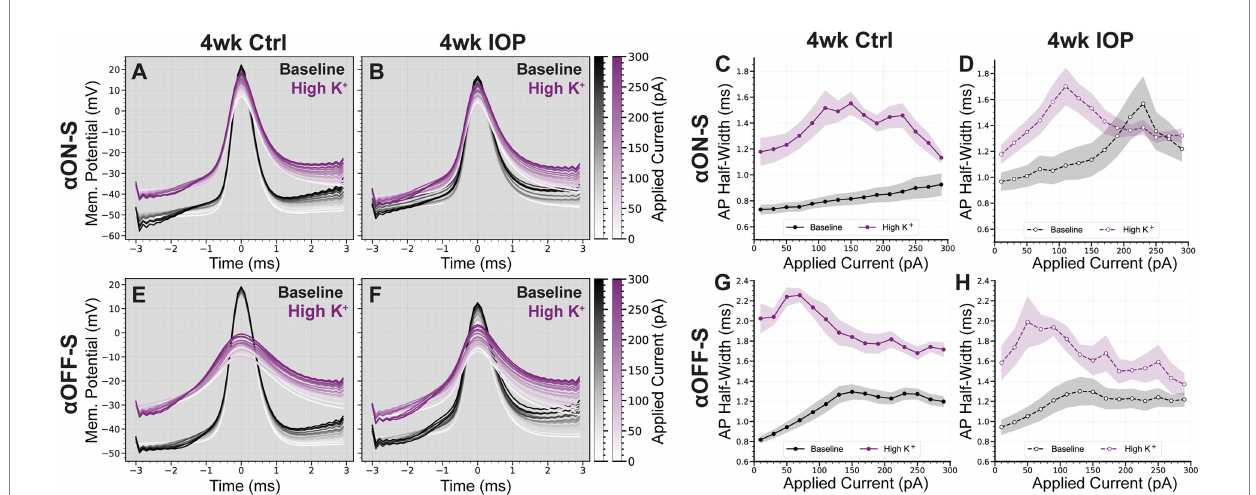
FIGURE 5 IOP elevation reduces the influence of high K + on action potential shape. (A,B) Mean action potential (AP) shapes of α ON-S cells in baseline and high K + conditions at each current step, for 4wk Ctrl (A) and 4wk IOP (B) groups. (C,D) Action potential half-widths of α ON-S cells in baseline and high K + conditions at each current step, for 4wk Ctrl (C) and 4wk IOP (D) groups. (E,F) Mean action potential (AP) shapes of α OFF-S cells in baseline and high K + conditions at each current step, for 4wk Ctrl (E) and 4wk IOP (F) groups. (G,H) Action potential half-widths of α OFF-S cells in baseline and high K + conditions at each current step, for 4wk Ctrl (C) and 4wk IOP (D) groups. The potassium-induced widening of action potentials is lessened after 4wks IOP elevation ( p = 0.0061, unpaired t -test). Shaded regions: ± standard error of the